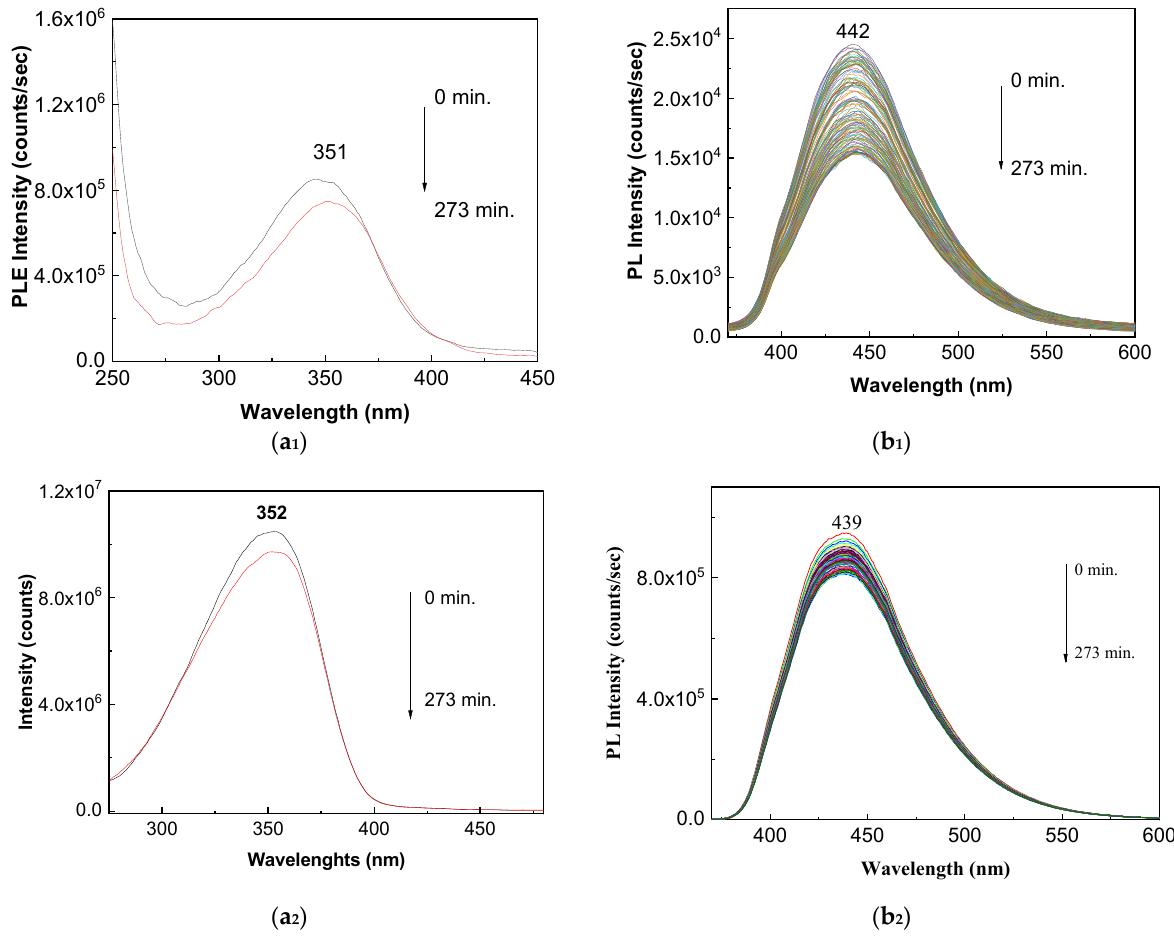
Figure 6. PL and PLE spectra of aqueous solution of AM ( a 1 , b 1 ) and AMP ( a 2 , b 2 ) and their behavior to the UV exposure; time of 273 min.